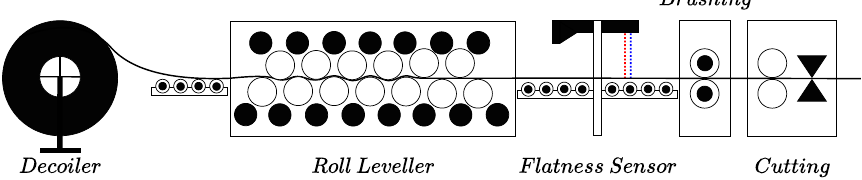
Figure 2. The experimental production line scheme and the optical flatness sensor placement. Blue and Red lines refer to laser planes used for pseudo-groundtruth calculation in real data experiments. Blue line refers to the laser plane which is further used for training, validation, and testing the proposed CBRDNet